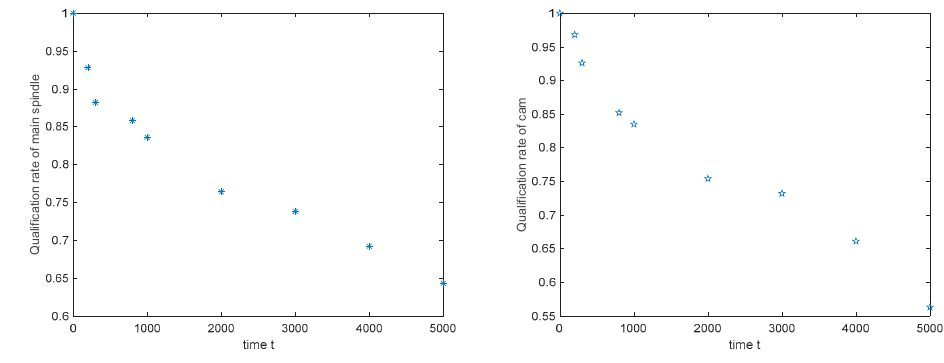
Figure 7. WIP qualification rate over time.